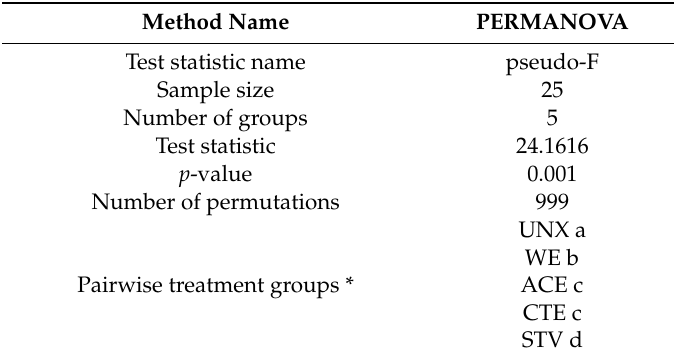
Figure 1. Principle coordinate analysis (PCoA) of a Bray–Curtis dissimilarity matrix from the hindgut bacteria detected in R. virginicus exposed to five groups. Each group is represented by a unique color and shape. Table 3. Permutational multivariate analysis of variance (PERMANOVA) analysis results for the significance of microbial community differences using the Bray–Curtis dissimilarity metric followed by pairwise treatment comparisons between sample groups.